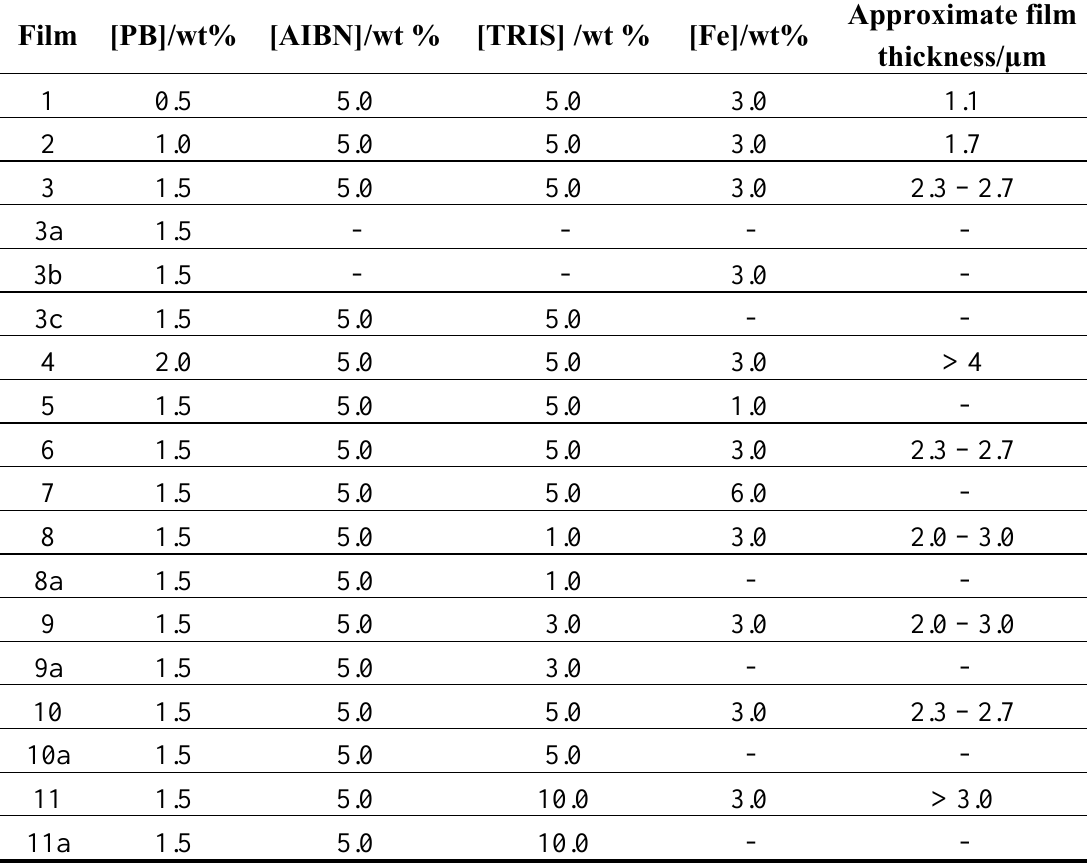
Table 1. Film composition and thickness. PB is poly(butadiene), AIBN is Azo-bis- (isobutyronitrile), TRIS is trimethylolpropane tris(3-mercaptopropionate), and Fe is iron oxide